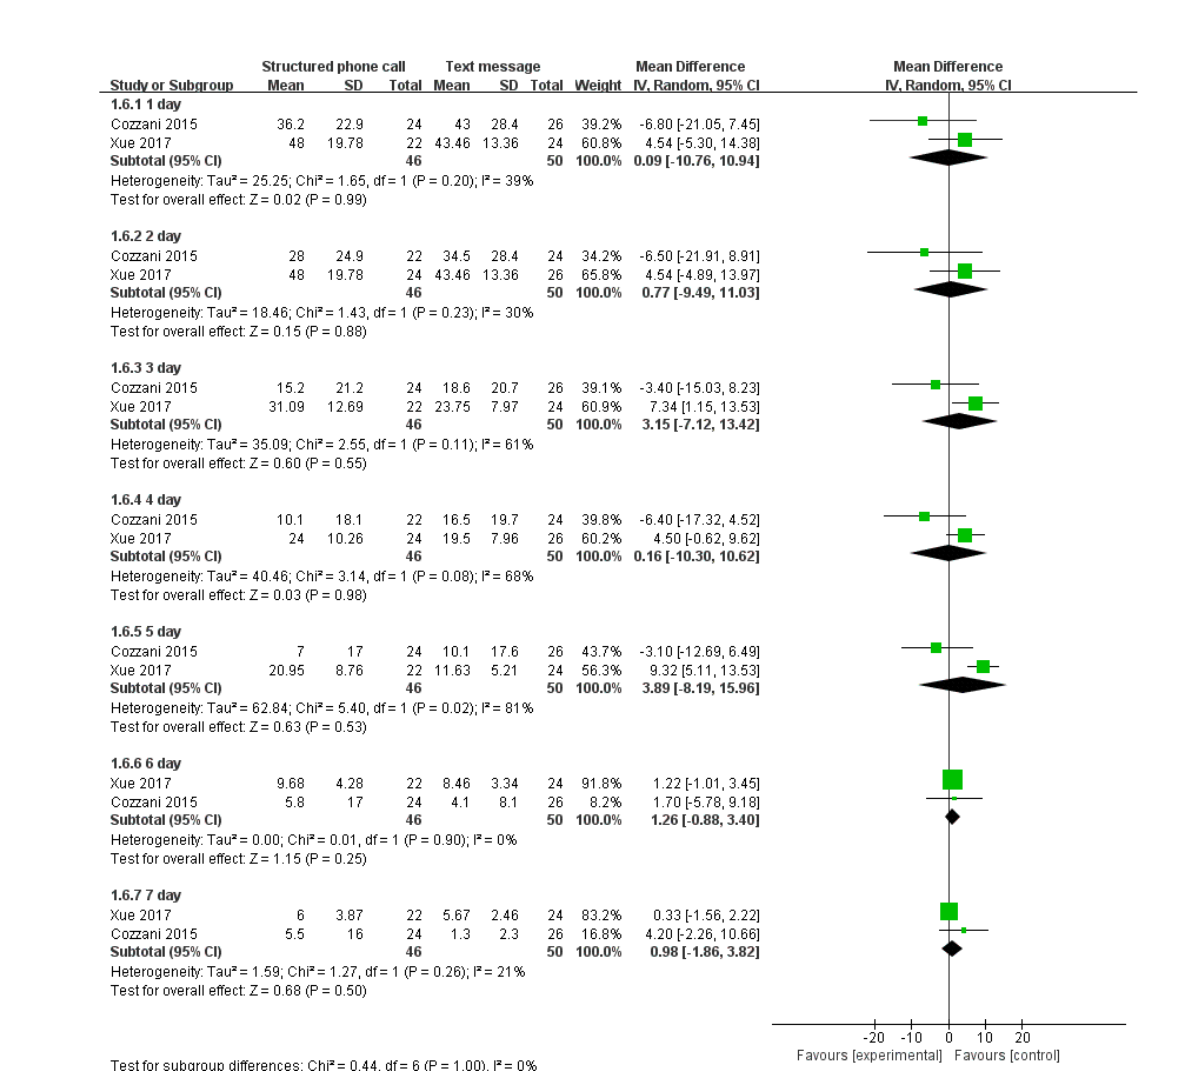
fixed orthodontic treatment. Supplementary Figure 6. Structured phone call follow-up and structured text follow-up for meta-analysis results, reported in mean difference (95% confidence interval), show evidence that both interventions’ pain reduction effectiveness is similar daily within a week after activation of